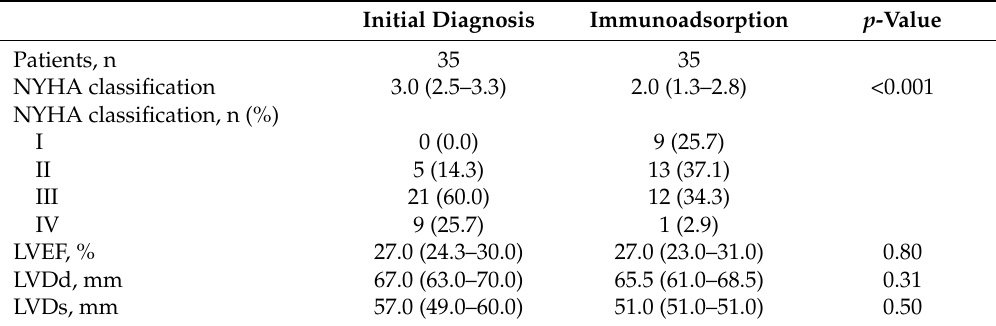
Table 2. New York Heart Association (NYHA) functional class and echocardiographic parameters at time point of initial diagnosis and immunoadsorption.